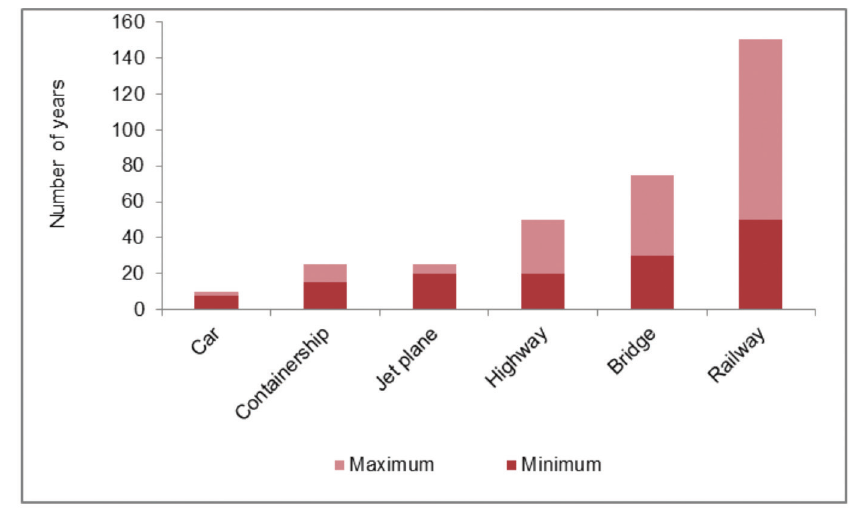
Figure 4: Lifespan of major transport assets (WWF,